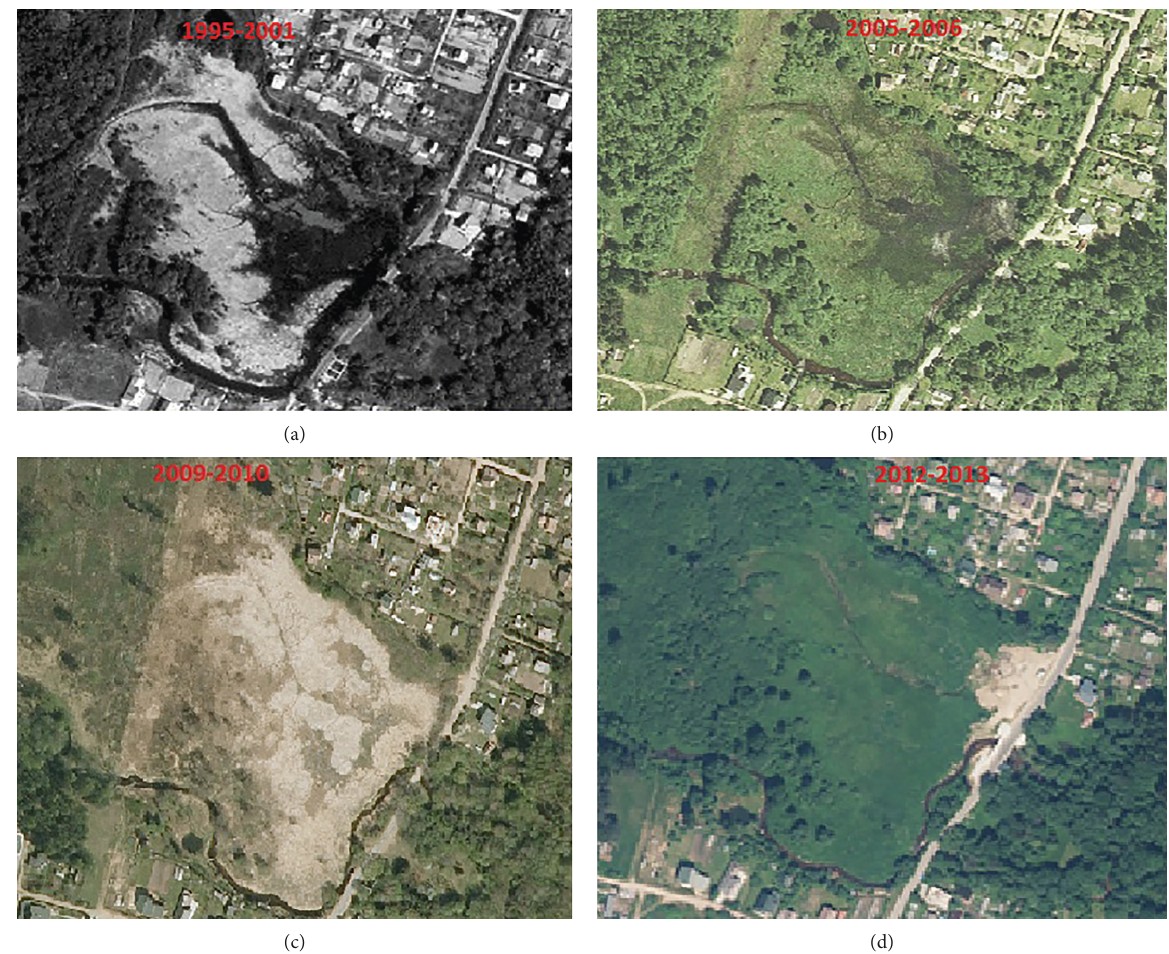
Figure 11: Digital raster orthophoto maps (source: http://www.geoportal.lt).